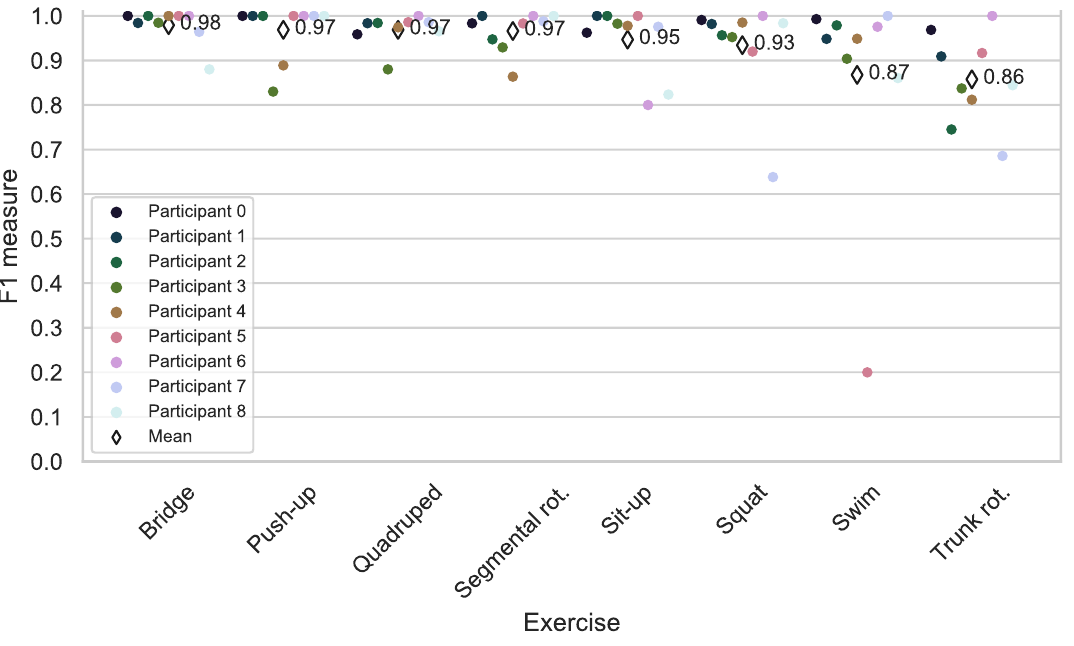
Figure 12. Exercise repetition counting results for each participant and exercise using template selection in the multi-user